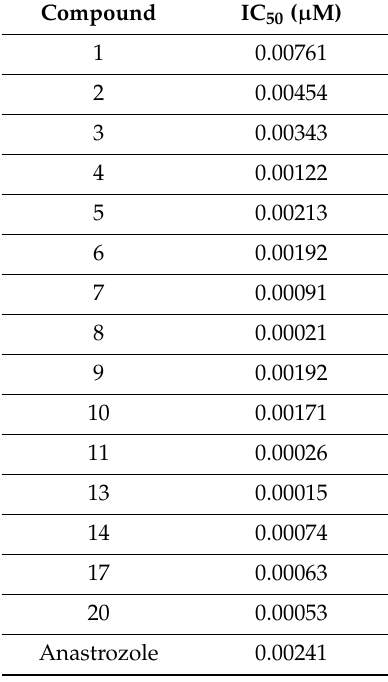
Table 1. 5 α -Reductase inhibitors activities and acute toxicity of the studied